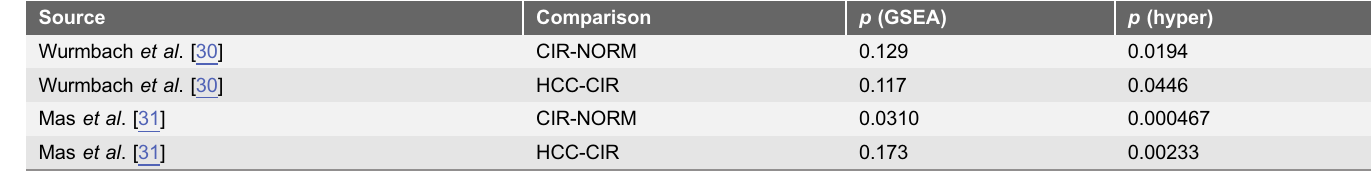
Table 3. Enrichment in HCV targets of differentially expressed genes in preneoplastic and neoplastic liver